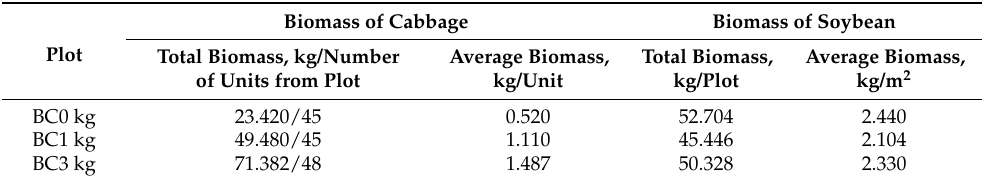
Table 1. Plant biomass of agricultural crops for the growing seasons of 2018 and 2019 from experi- mental plots on the territory of the Primorskaya Vegetable Experimental Station. Biomass of Cabbage Biomass of Soybean Plot Total Biomass, kg/Number Average Biomass, Total Biomass, of Units from Plot kg/Unit